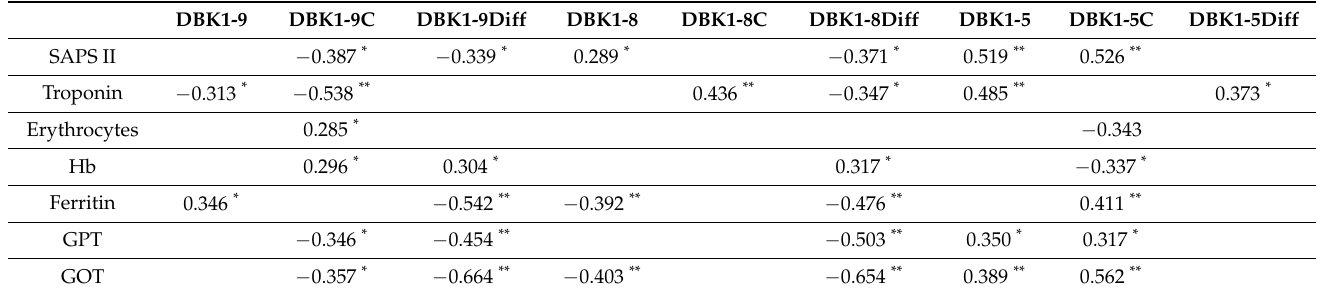
Table 3. Pearson correlations for bivariate correlations of NRA data with and without inhibition for hospitalized patients (HoP) and the reference group of convalescent patients (CoP-NV) with clinical parameters. * significant at the 0.05 level, ** significant at the 0.01